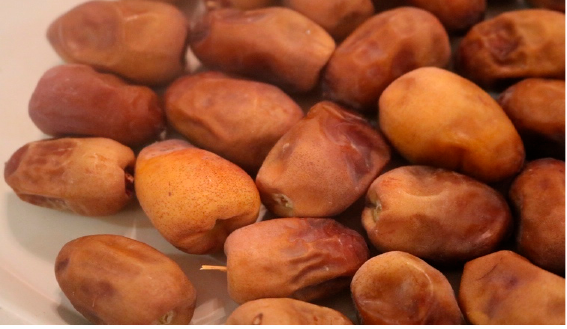
Figure 26. Sample of NbotAli dates.